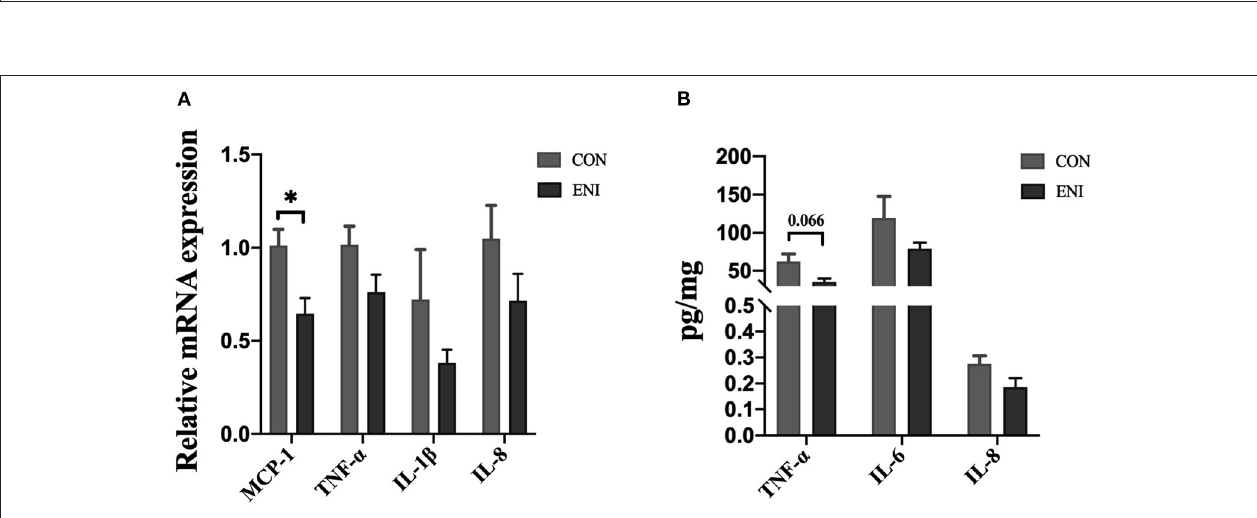
FIGURE 4 | Effects of early-life nutrition interventions on inflammation in the piglet colon. CON, control group, ENI, early-life nutrition interventions group. (A) The mRNA expression levels of MCP-1, TNF- α , IL-1 β , and IL-8 in colon. (B) The protein expression levels of TNF- α , IL-6, and IL-8 in piglets. Data are expressed as mean ± SEM ( n = 4). The independent-samples t -test was used to compare data between two groups. * P < 0.05.